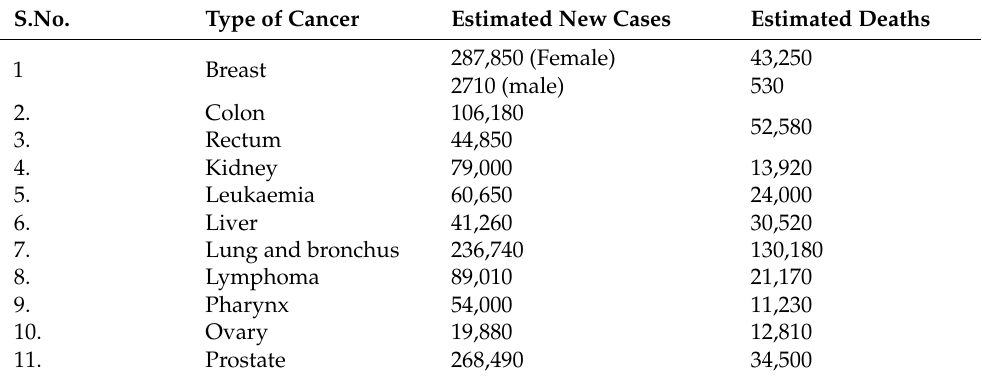
Table 1. Various types of cancers with estimated number of new cases and deaths in 2022 in US [4]. S.No. Type of Cancer Estimated New Cases Estimated